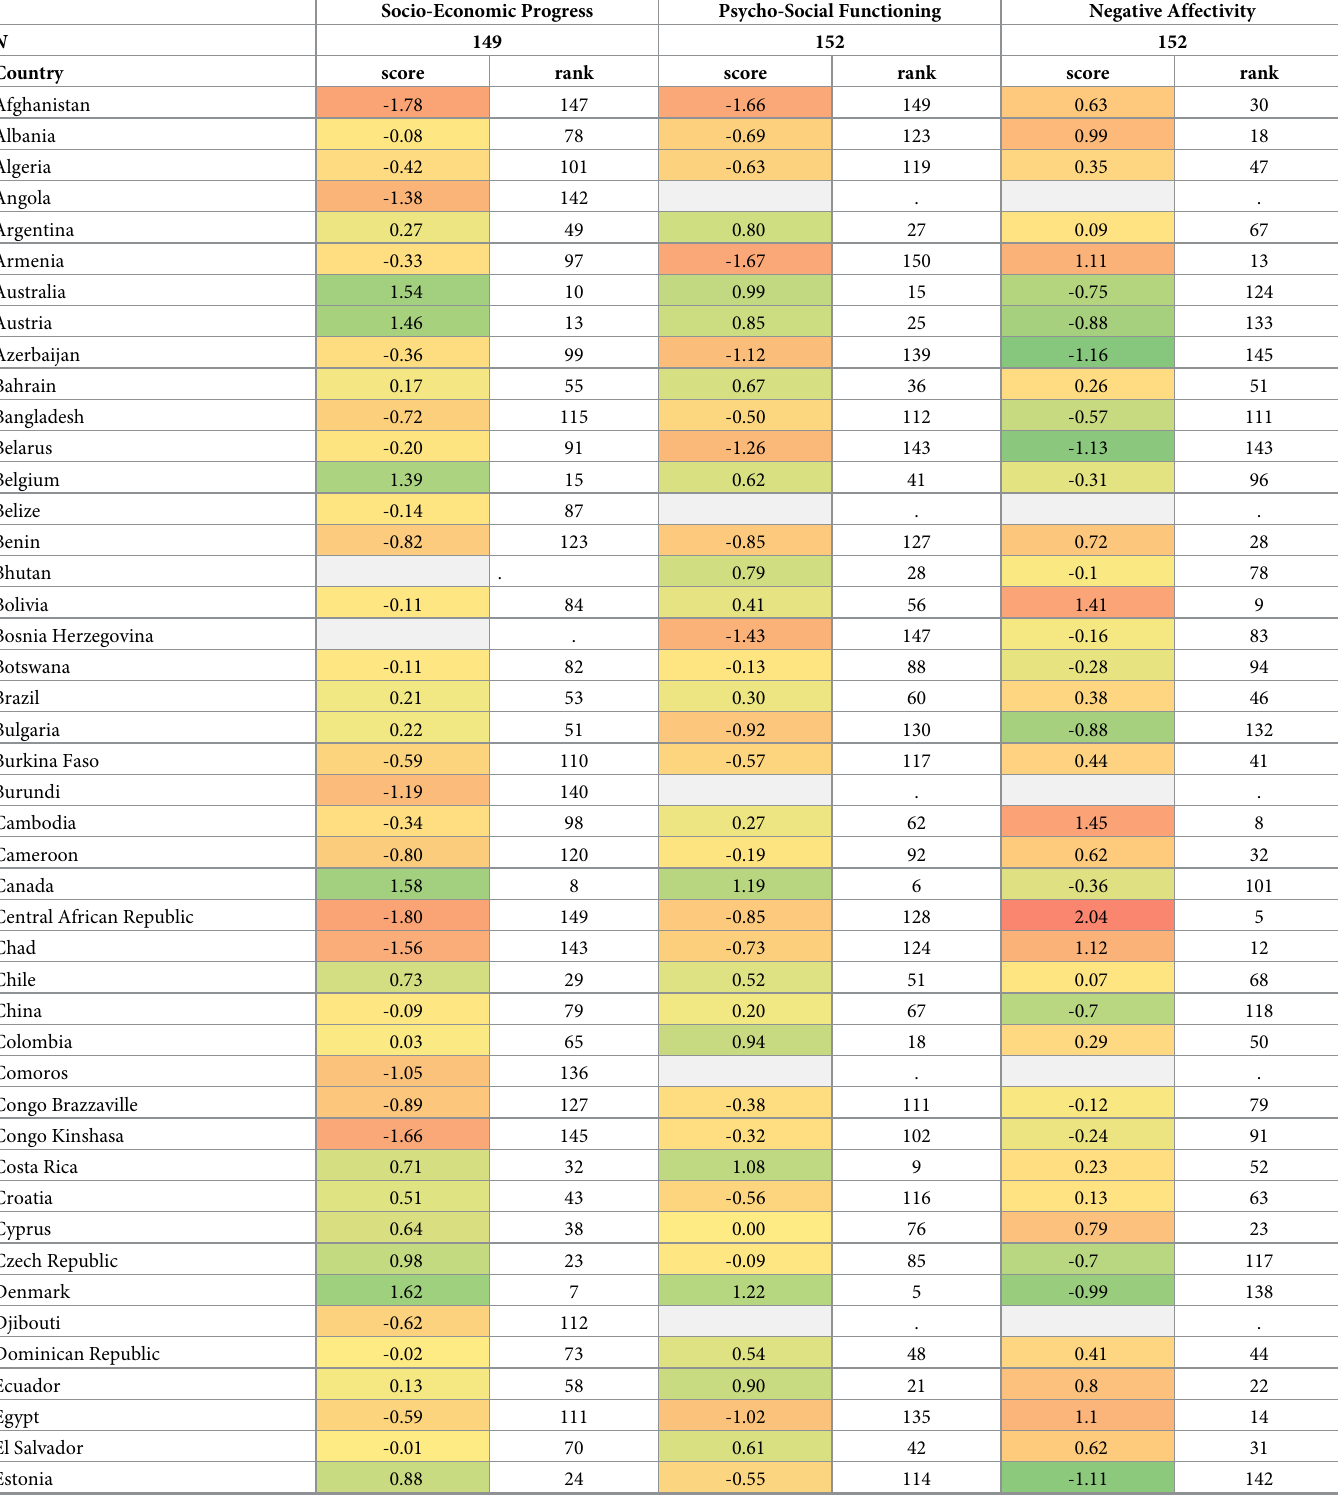
Table 6. Country